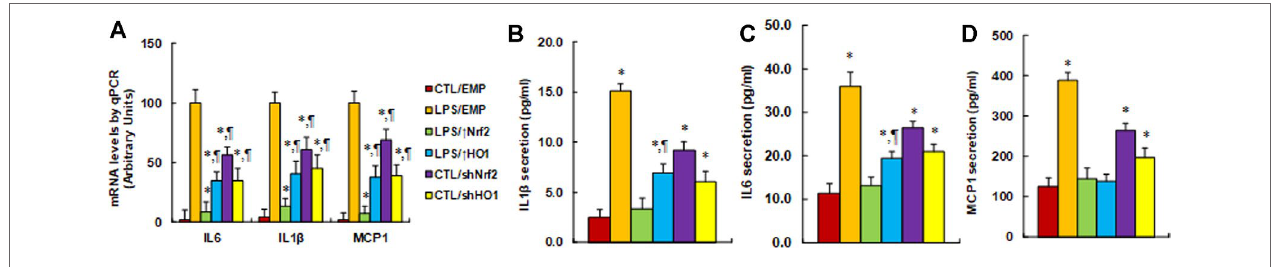
FIGURE 3 | Expression of Nrf2/HO1 prevents, while knockdown of Nrf2/HO1 mimics, hyperglycemia-induced expression of proinflammatory cytokines. Rat macrophages were infected by an empty vector (EMP), Nrf2 lentivirus (Nrf2 ↑ ), HO1 lentivirus (HO1 ↑ ), Nrf2 knockdown (shNrf2), or HO1 knockdown lentivirus (shHO1) and then incubated in either control (CTL) or 5 ng/mL LPS, and the cells were harvested on day 5 for analysis. (A) mRNA levels by qPCR, n = 4. * P < 0.05, vs LPS/EMP group; ¶ P < 0.05, vs LPS/Nrf2 ↑ group. (B) IL1 β secretion, n = 5. * P < 0.05, vs CTL/EMP group; ¶ P < 0.05, vs LPS/EMP group. (C) IL6 secretion, n = 5. * P < 0.05, vs CTL/EMP group; ¶ P < 0.05, vs LPS/EMP group. (D) MCP1 secretion, n = 5. * P < 0.05, vs CTL/EMP group. Data were expressed as mean ±